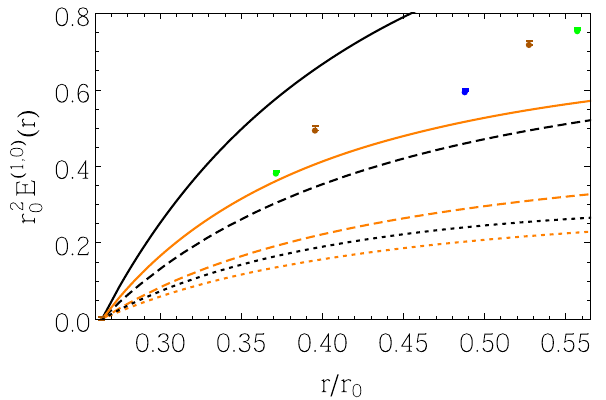
Fig. 5 Comparison to the lattice data for E ( 1 , 0 ) ( r ) . The solid lines correspond to the LO (orange) and NLO results (black) at fixed scale ν = 2 × 1 / 0 . 263821 r − 1 . The dashed lines correspond to the LO 0 (orange) and NLO (black) setting ν = 3 / r . The dotted lines correspond to the LL (orange) and NLL results (black) setting ν us = 2 C A α(ν)/ r and ν = 3 / r